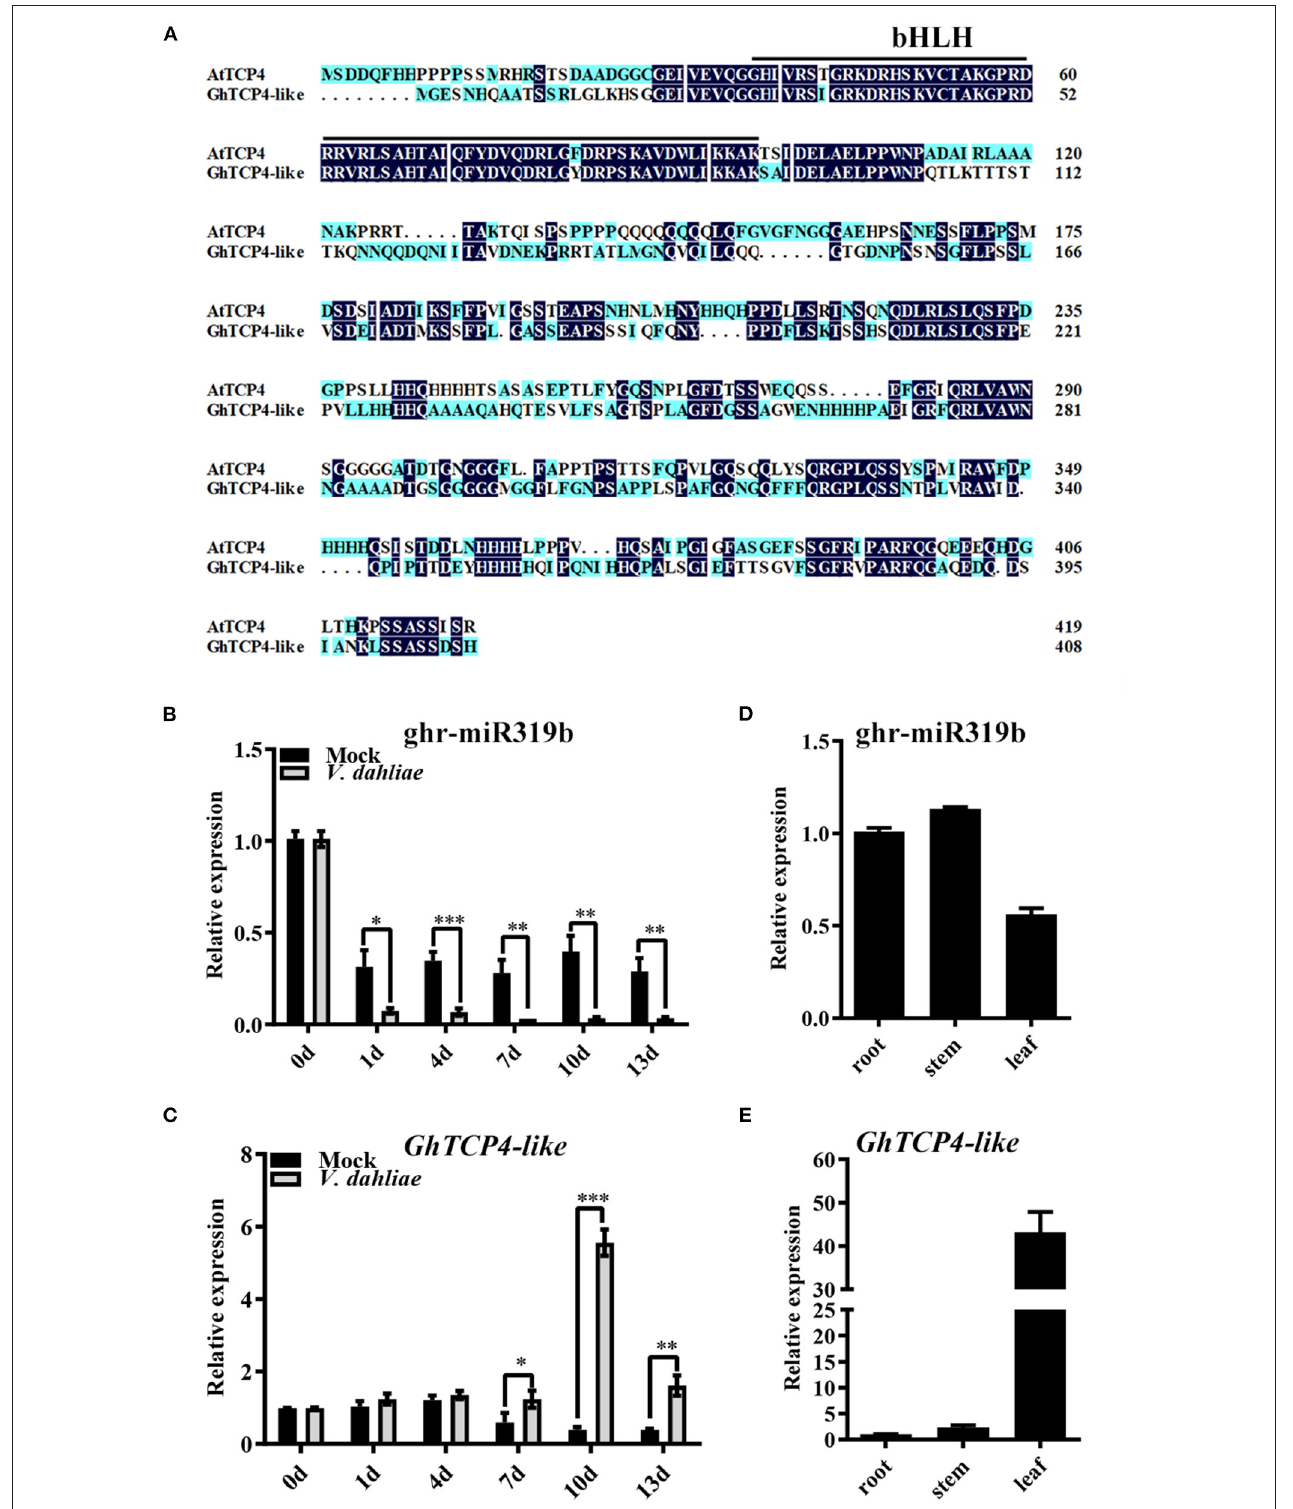
FIGURE 1 | GhTCP4-like characterization and expression patterns of ghr-miR319b and GhTCP4-like. (A) Amino acid sequence alignment of GhTCP4-like and AtTCP4. The solid black underline indicates the TCP domain (a non-standard bHLH domain). (B,C) qPCR analysis of ghr-miR319b and GhTCP4-like expression